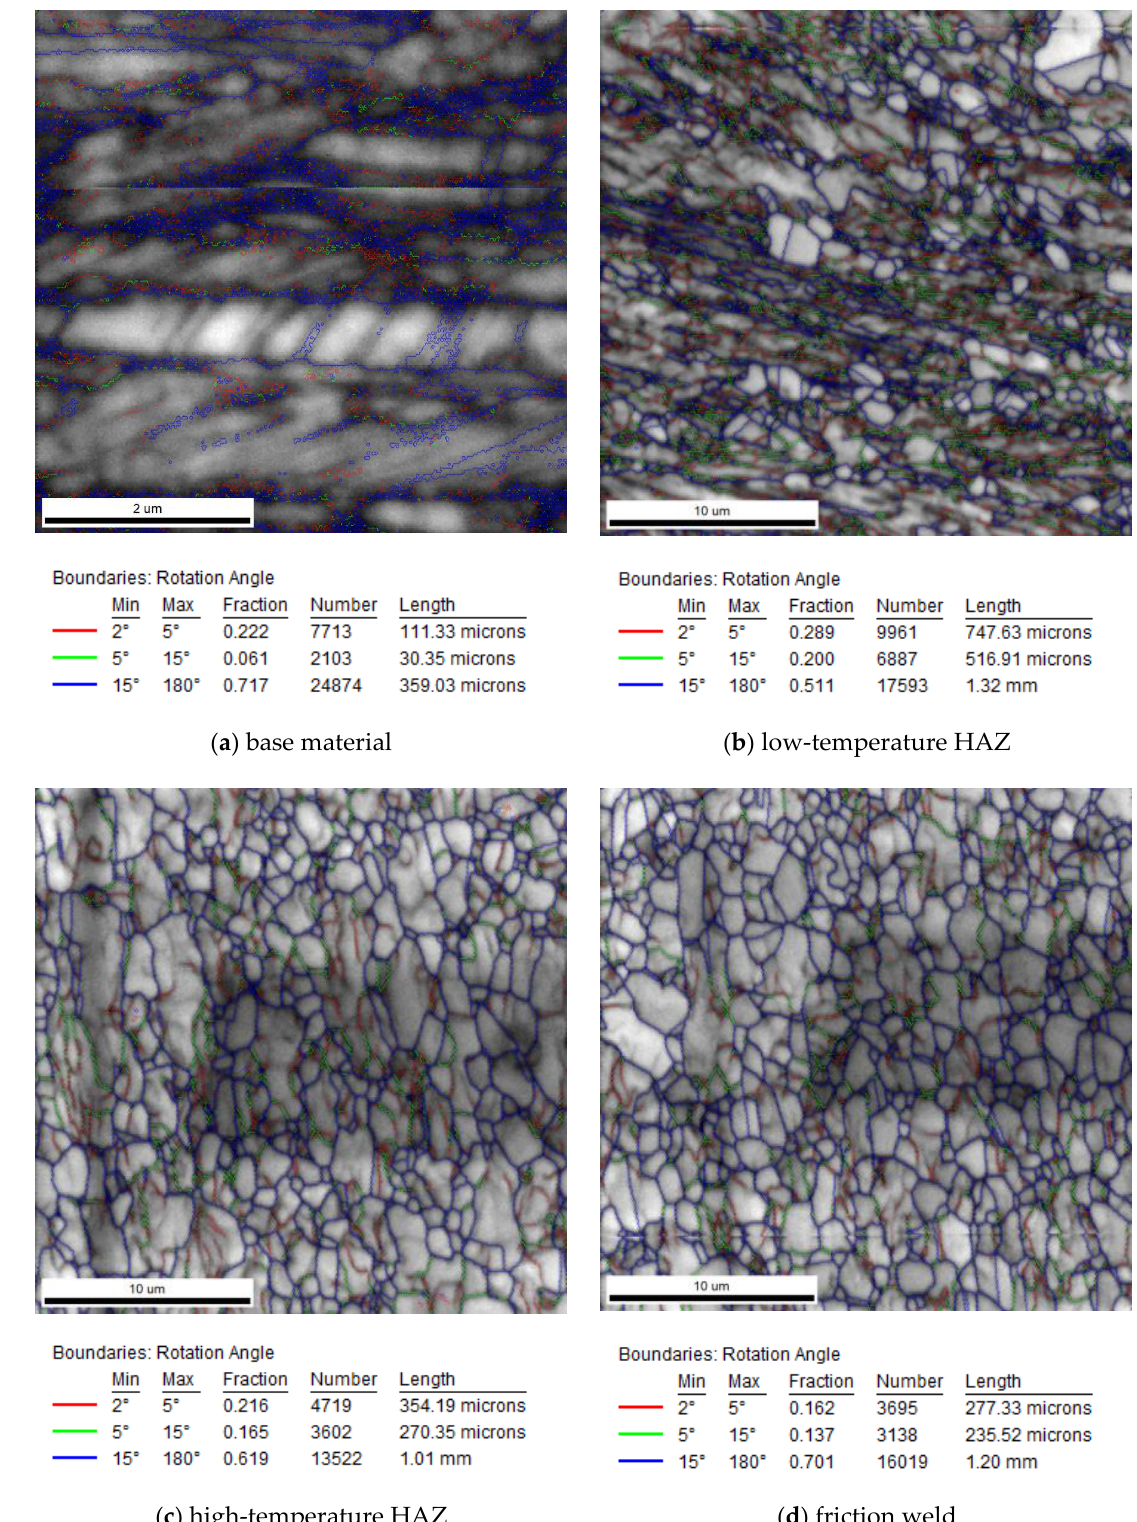
Figure 8. The micropatterns of the misorientation grain boundaries for different areas of the weld (corresponding to IPF maps).